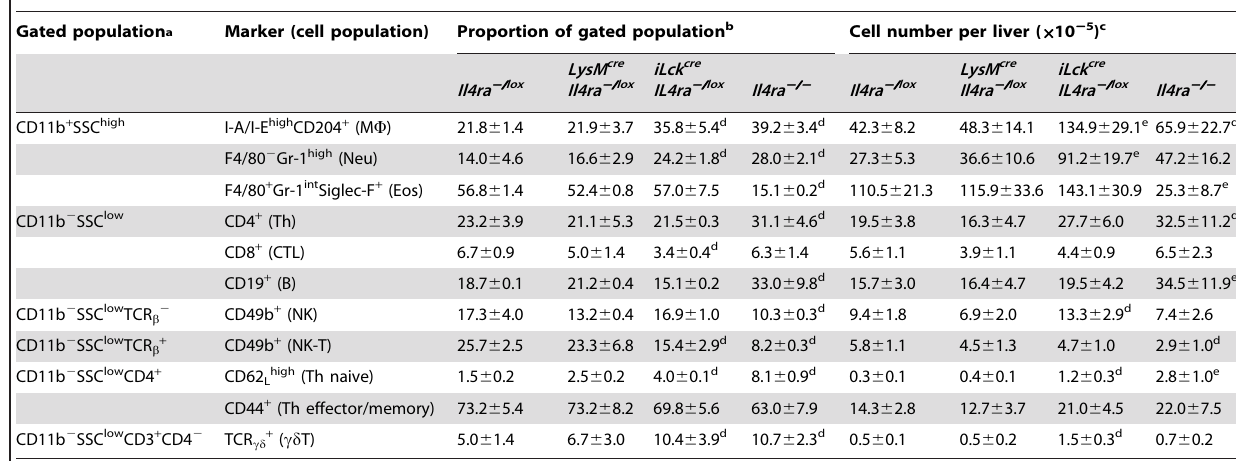
Table 2. Cellular composition of liver granulomas depending on macrophage/neutrophil or T cell-specific IL-4R a deletion.